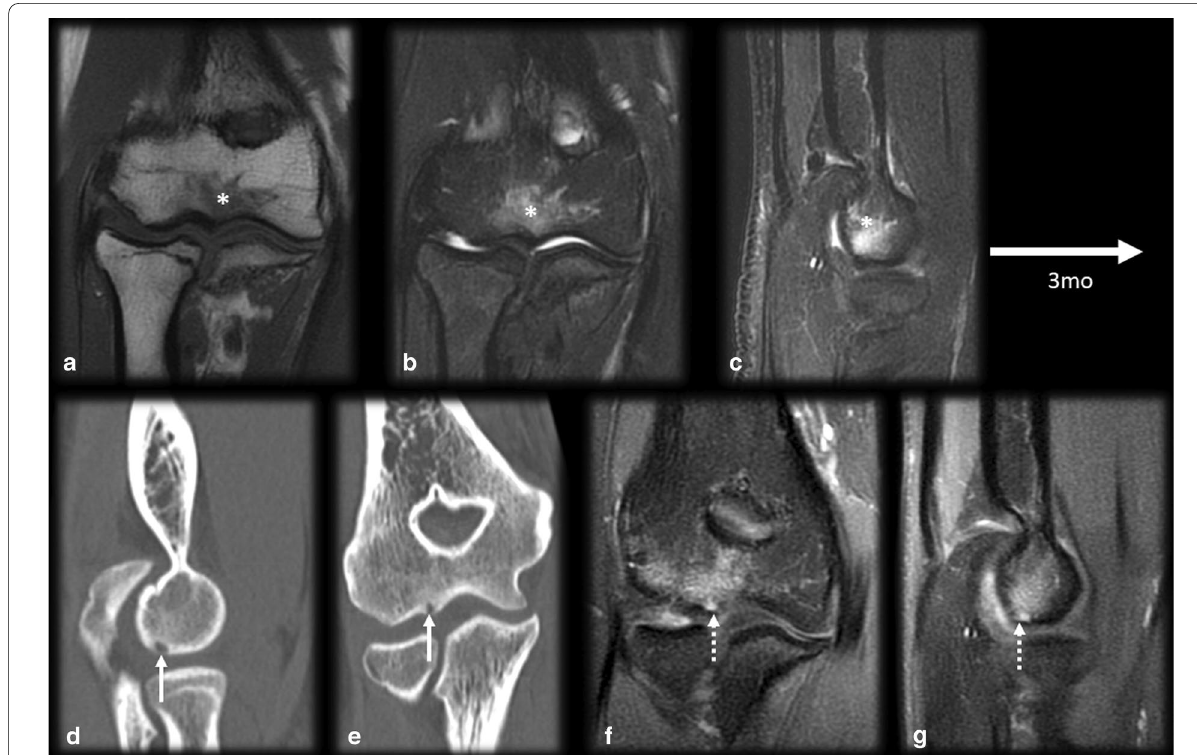
Fig. 16 Osteoid osteoma mimicking bone marrow contusion. Male, 16 years old, presenting with right elbow and arm pain for 2 days after falling during physical activity at school. First, the MRI T1 ( a ) and T2 FS ( b , c ) findings were interpreted to indicate contusion bone marrow edema (asterisks) without a fracture. However, the pain persisted for more than 3 months. Follow-up CT ( d , e ) and MRI ( f , g ) scans revealed small subchondral OO with a lytic nonmineralized nidus (arrows) and enhancement (dotted arrows) on the T1 FS GD MRI scan ( f , g